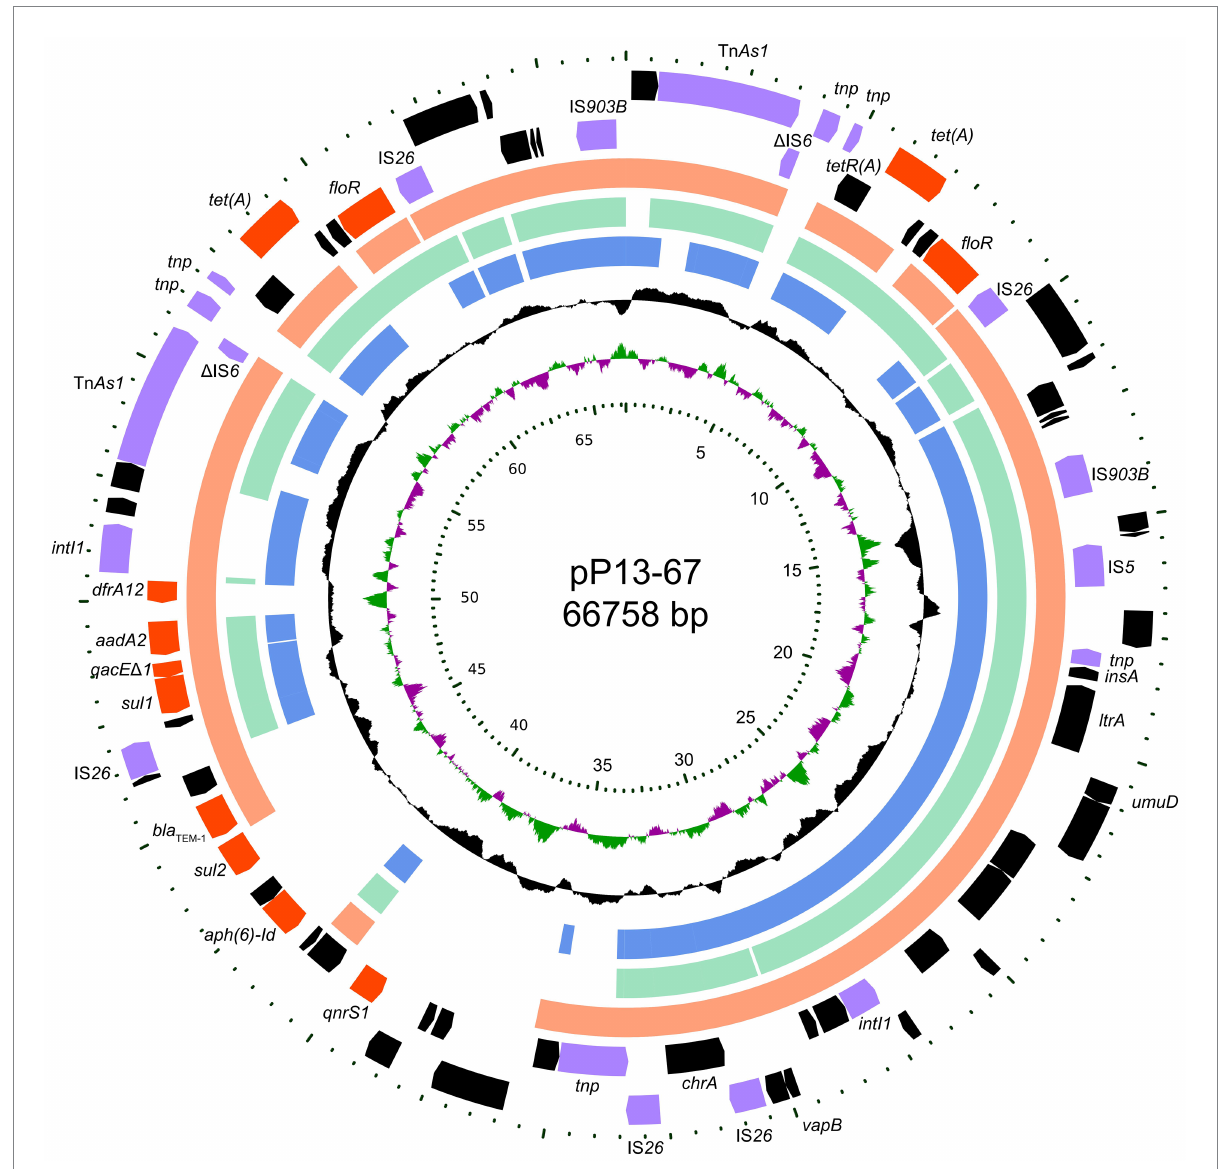
FIGURE 1 Circular map of pP13-67 and comparative genomic analysis with other closely related plasmids. From inside to outside: Circle 1 shows the scale in kb. Circles 2 and 3 display the GC skew and GC content, respectively. Circles 4–6 show the homologous sequences of pEcl5-2 of Enterobacter hormaechei Eho-5 (CP047738.1), pN56639 of Escherichia coli CVM N56639 (CP043753.1) and p1 of Klebsiella pneumoniae JM45 (CP006657.1), respectively, while areas displaying different features have been left blank. Circles 7 and 8 present genes encoded in the reverse and forward strands of pP13-67,